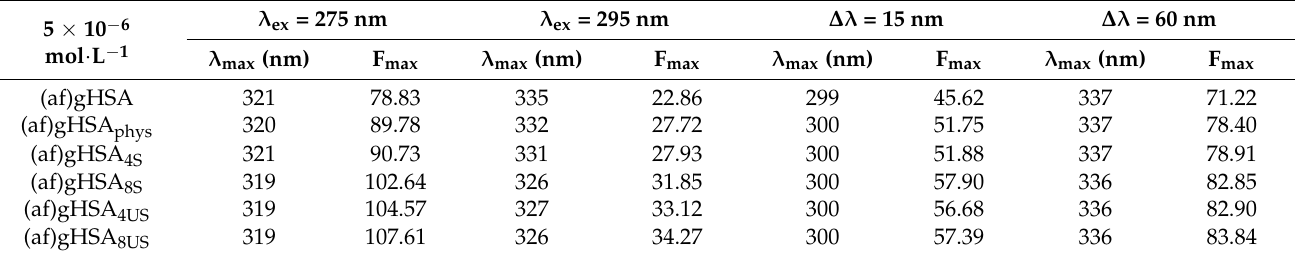
Table 4. Intensity of 5 × 10 − 6 mol · L − 1 (af)gHSA, (af)gHSA phys , (af)gHSA 4S , (af)gHSA 4US , (af)gHSA 8S , and (af)gHSA 8US emission ( λ ex = 275 nm, λ ex = 295 nm) and synchronous ( ∆ λ = 15 nm and ∆ λ = 60 nm) fluorescence